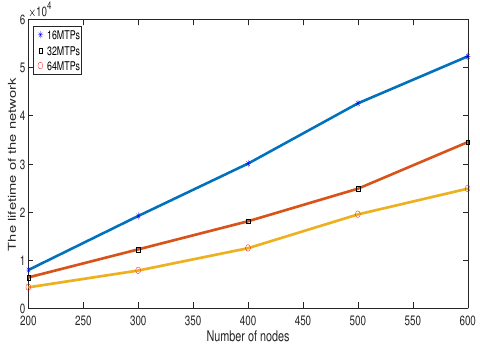
Figure 14. The lifetime of the